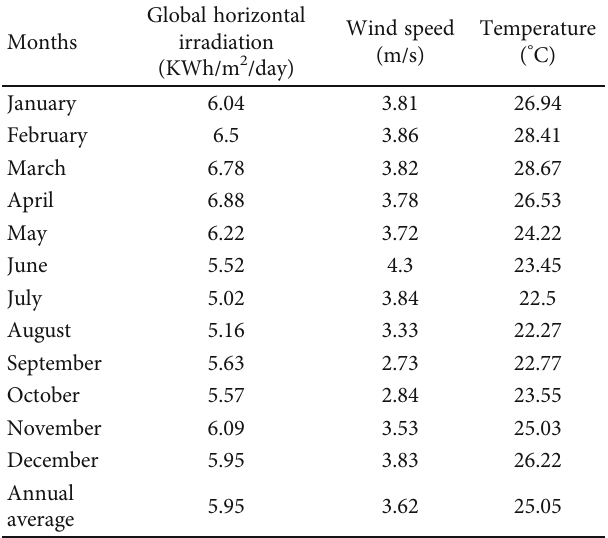
Table 2: Metrological data of Great Ethiopian Renaissance Dam (GERD).